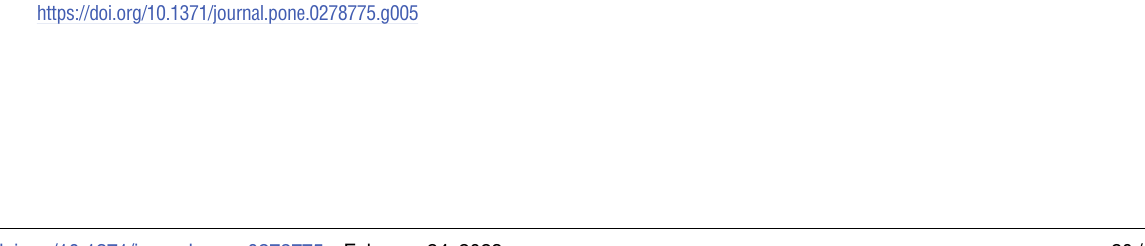
PLOS ONE | https://doi.org/10.1371/journal.pone.0278775 February 24,